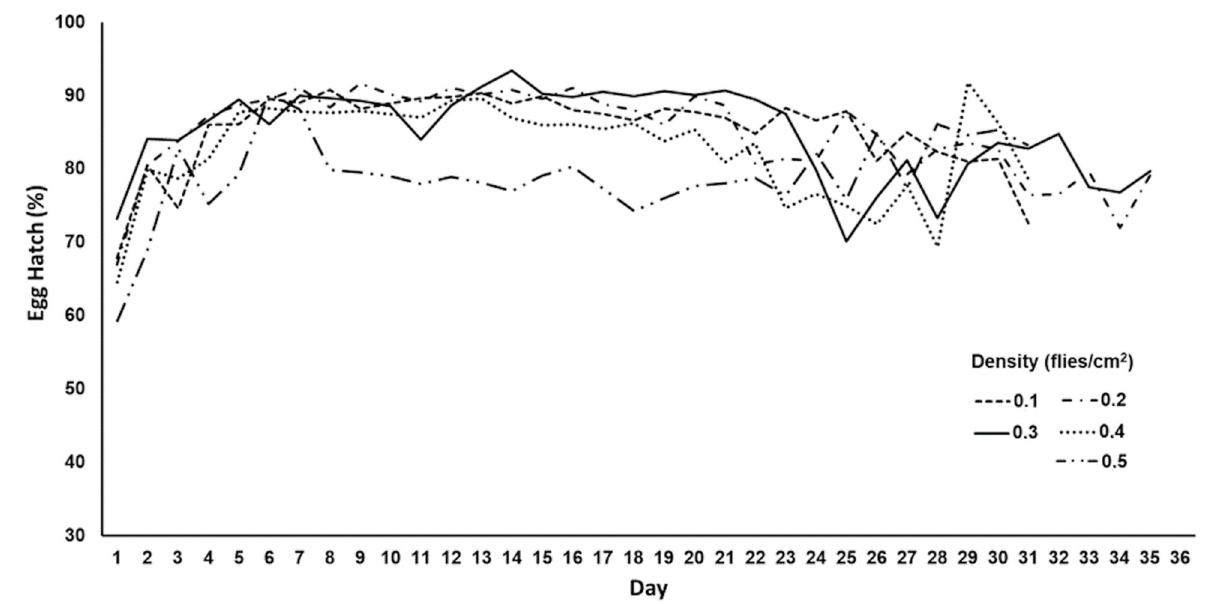
Figure 2. Mean daily hatch of eggs produced by Anastrepha fraterculus flies maintained at five different adult densities. Table 2. Mean daily and total egg production per cage and egg hatch (mean ± SE) for the period between day 1 and day 30 of oviposition from cages with Anastrepha fraterculus flies at different adult densities. Adult Density (flies/cm 2 )